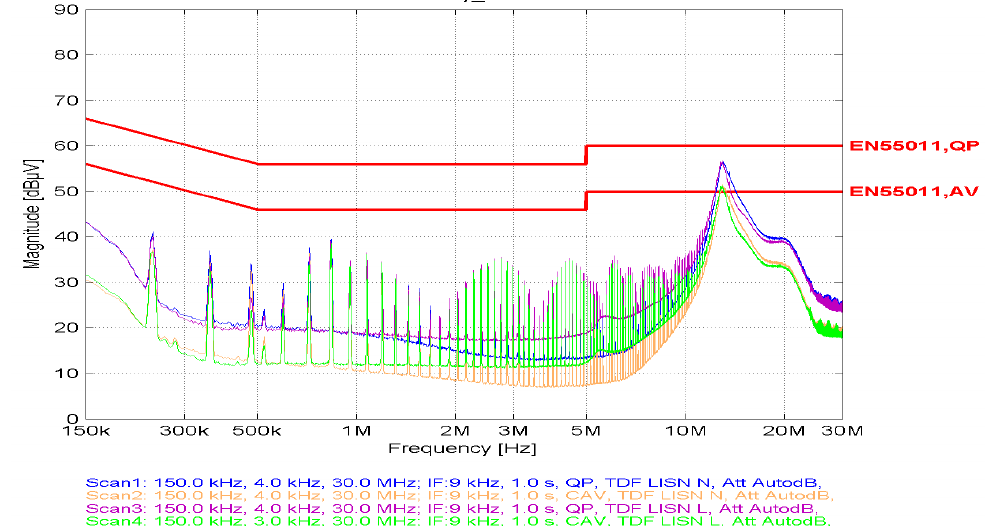
Figure 11. Attenuation level for ferrite No. 2 with the number of coils at 38 pcs. In the case of reducing the ferrites, it can be seen that the obtained level of attenuation decreases and is far from the set limit. On the other hand, in the case of increasing the number of ferrites above the base computational level, the level of attenuation increases dramatically, but remains within the acceptable values. At the same time, when increasing by a few more ferrites, it confirms the tendency of no justification for increasing the number of turns above the base computational level. In the performed measurements, the step was the same, but the difference in the maximum attenuation level in the 500 kHz–2 MHz frequency range between the analyzed cases is 5